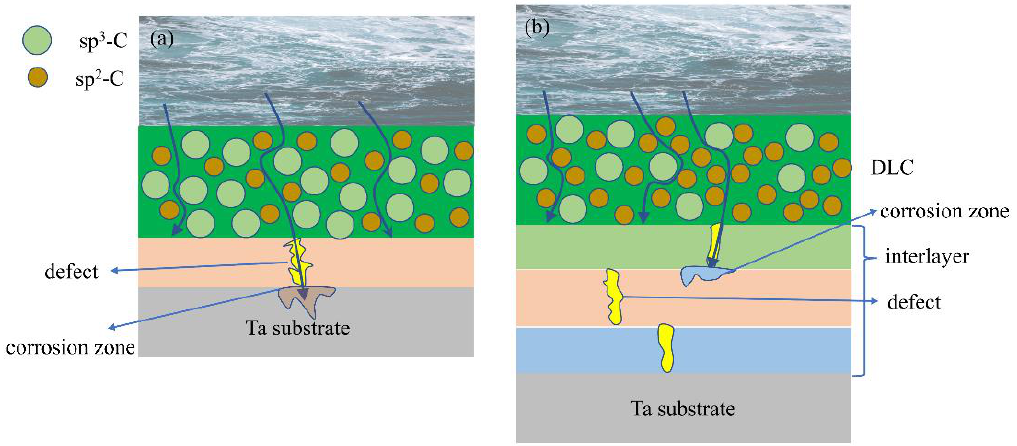
Figure 14. Corrosion mechanisms of ( a ) TD film and ( b ) TTTD film.